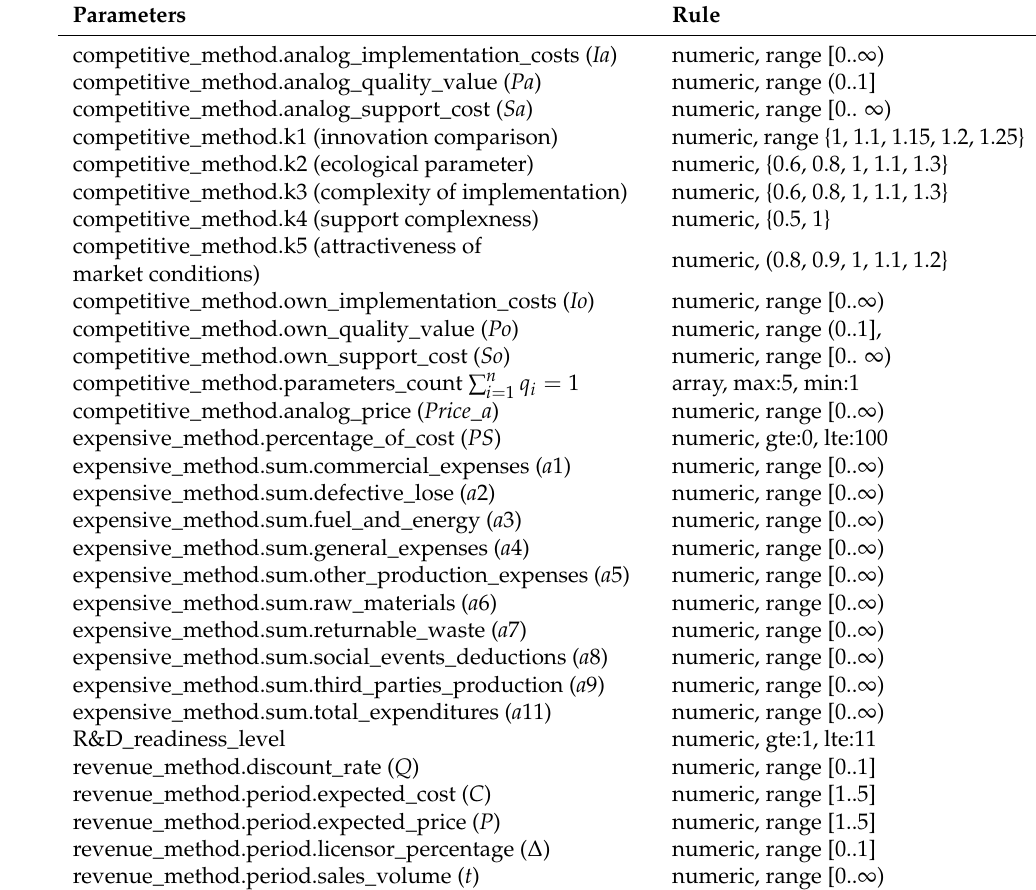
Table 7. Parameters for cost estimation for R&D products.